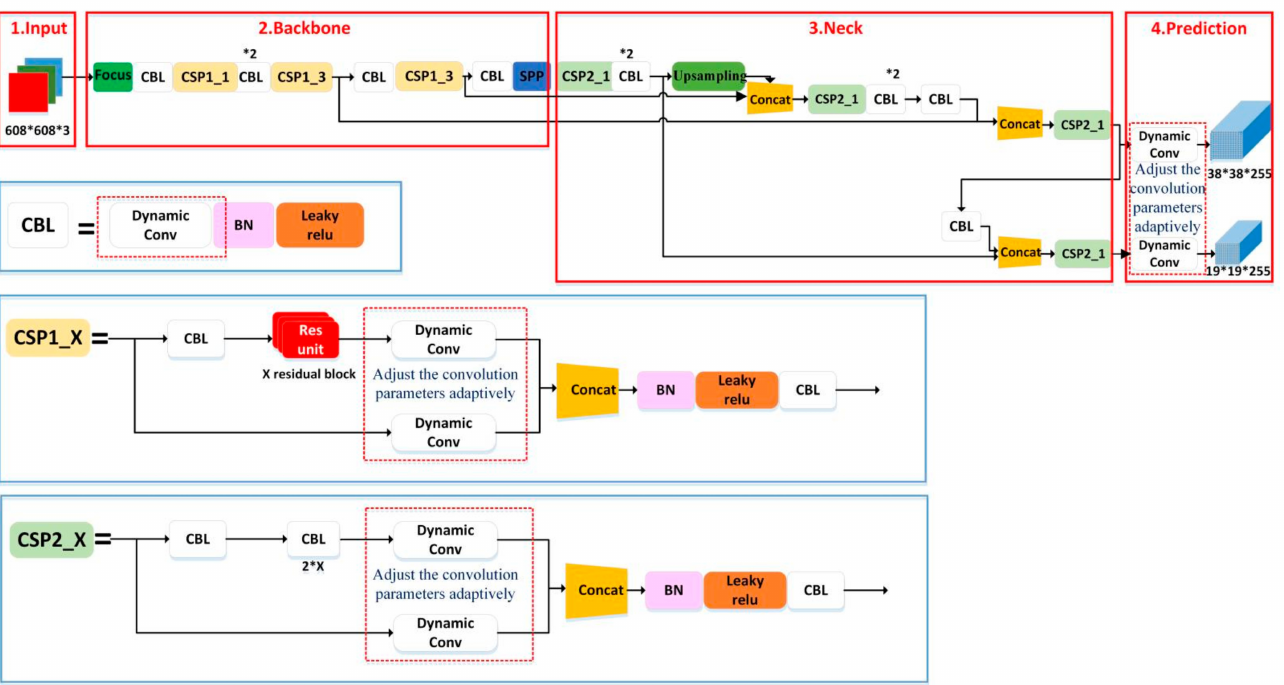
Figure 3. Dynamic convolution YOLOv5 network model